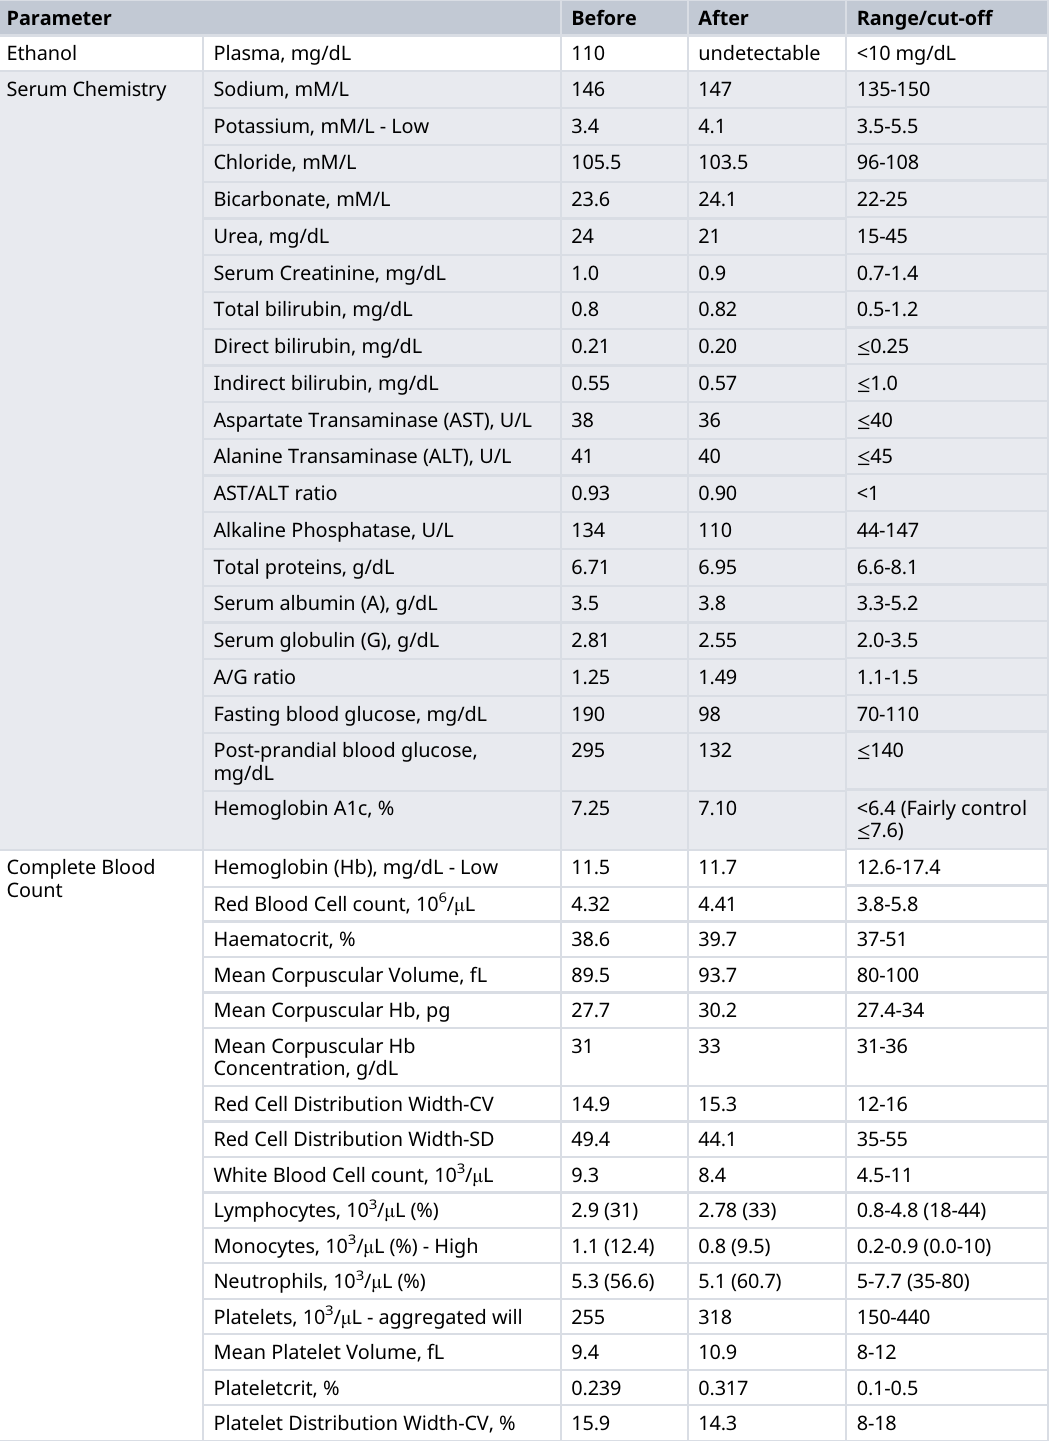
Table1.Thechangesinbloodethanolandlaboratoryworkupofthecasebeforeandfivedaysaftertreatment. Data shown are contents of the investigated parameters and their normal reference range/cut-off values. CV = coefficient of variation from the mean, and, SD = standard deviation from the